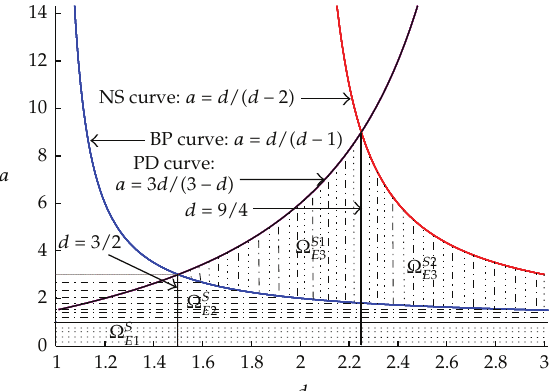
Figure 1: Stability regions in (cid:3) d,a (cid:4) -space. Ω S E stability region Ω S E